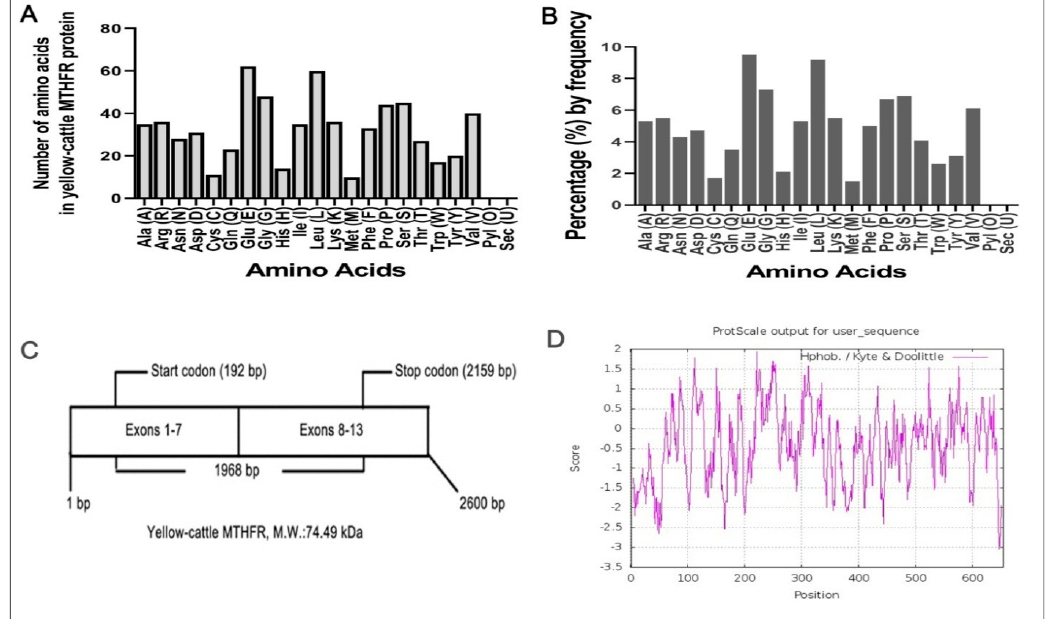
Figure 3. ( A , B ) Amino acid residues in yellow-cattle MTHFR protein, ( C ) Structure of MTHFR transcript, ( D ) Hydrophobicity analyses of the encoding product of yellow-cattle MTHFR protein. Table 4. Comparison of yellow-cattle ( Bos taurus ) MTHFR and other MTHFR proteins from various, mostly similar, mammals (with high percentage identity value of between 100 to